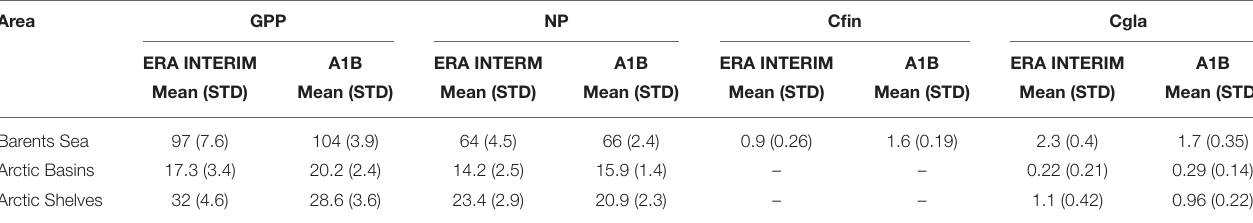
TABLE 1 | Comparison between of simulated mean rates for the 2001–2010 period for ERA INTERIM and A1B for different regions of the AO [mean and standard deviation (STD)].